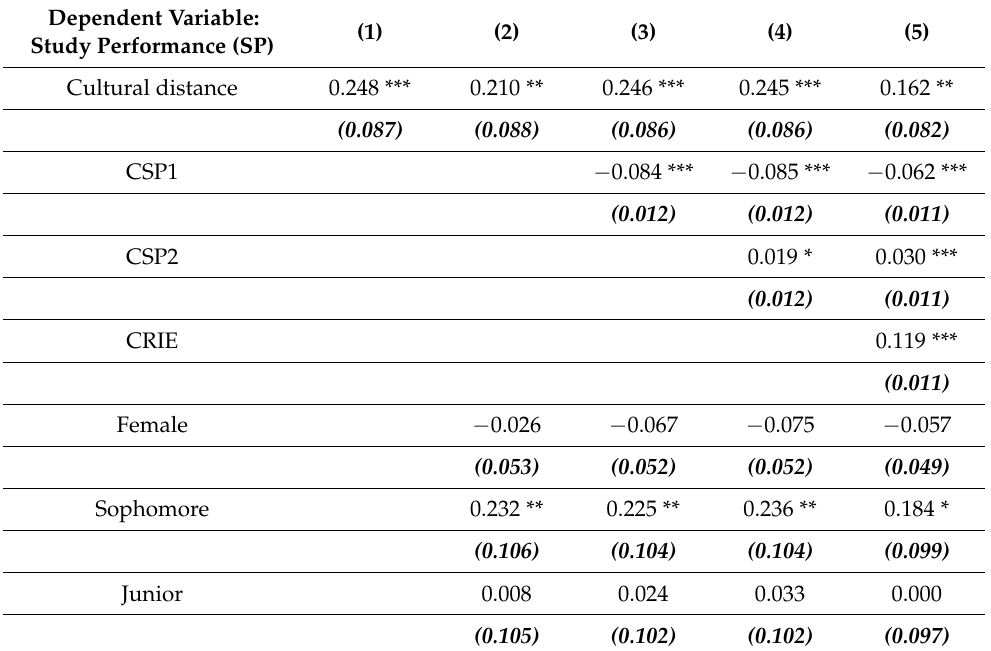
Table 2. Estimated effects of cultural distance, classroom silence, and CRIE on study performance by using Equation